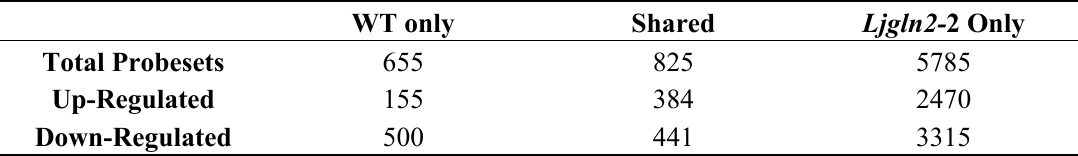
Table 1. Probesets modulated by 2-days transfer from CO photorespiration) to normal air (active photorespiration) atmosphere in the leaf transcriptomics of either WT or Ljgln2-2 mutant plants.